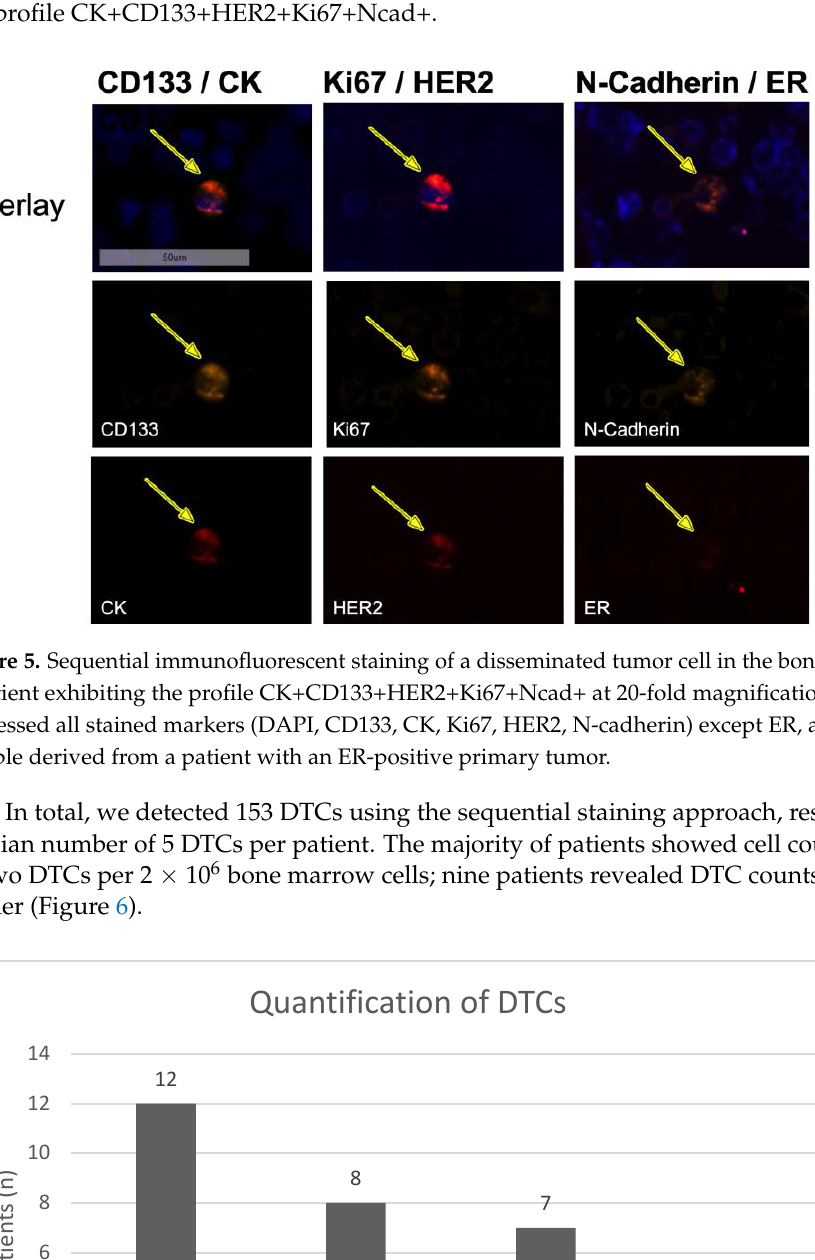
8 of 22 Figure 4. Staining of ZR75-1 cells (white arrows), which stain positive for ER (red) while remaining negative for N-cadherin, next to T98G cells (yellow arrows), which stain positive for N-cadherin (yellow) and negative for ER at 20-fold magnification.